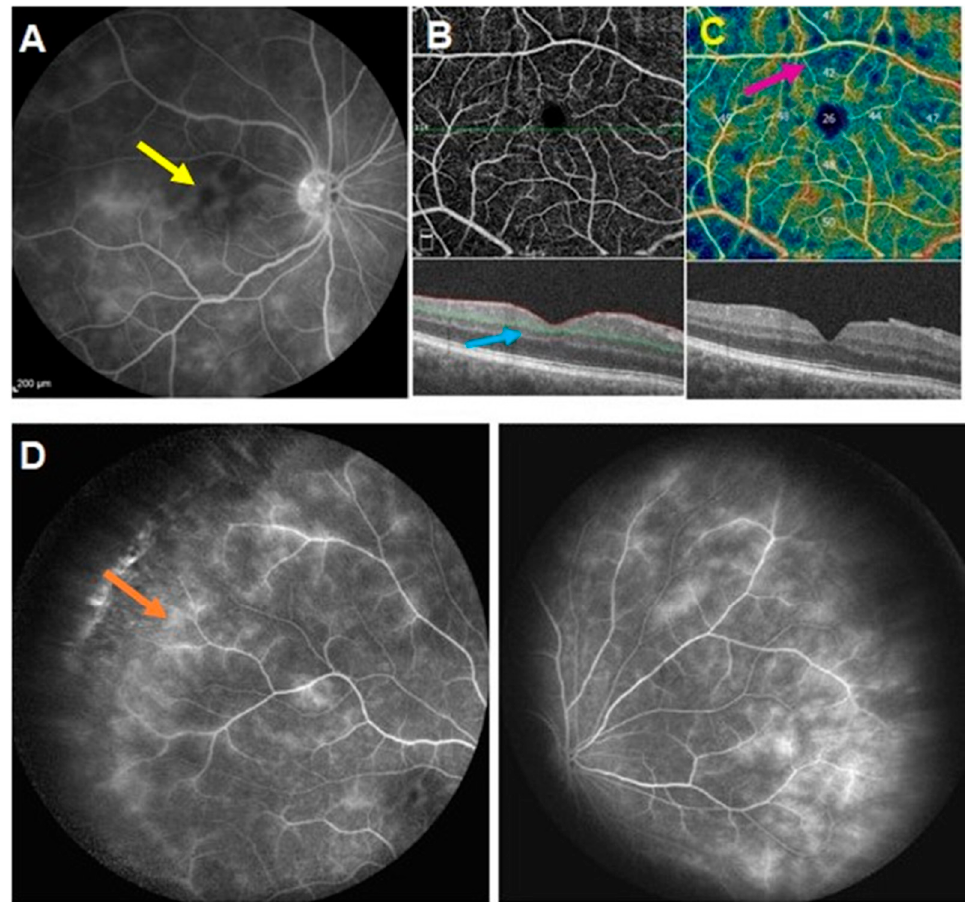
Figure 1. Behcet Uveitis, same ‐ day imaging. ( A ) Fluoresceine angiography of the posterior pole showing macular edema (yellow arrow). ( B ): en face ( top ) and cross ‐ sectional ( bottom ) OCT ‐ A scans of the same patient. Macular edema is not detected by the cross ‐ sectional scan (blue arrow). ( C ) vascular density showing defects of the superficial plexus (Grimson arrow). ( D ) Fluoresceine of the periphery showing mild vasculitis (orange arrow).